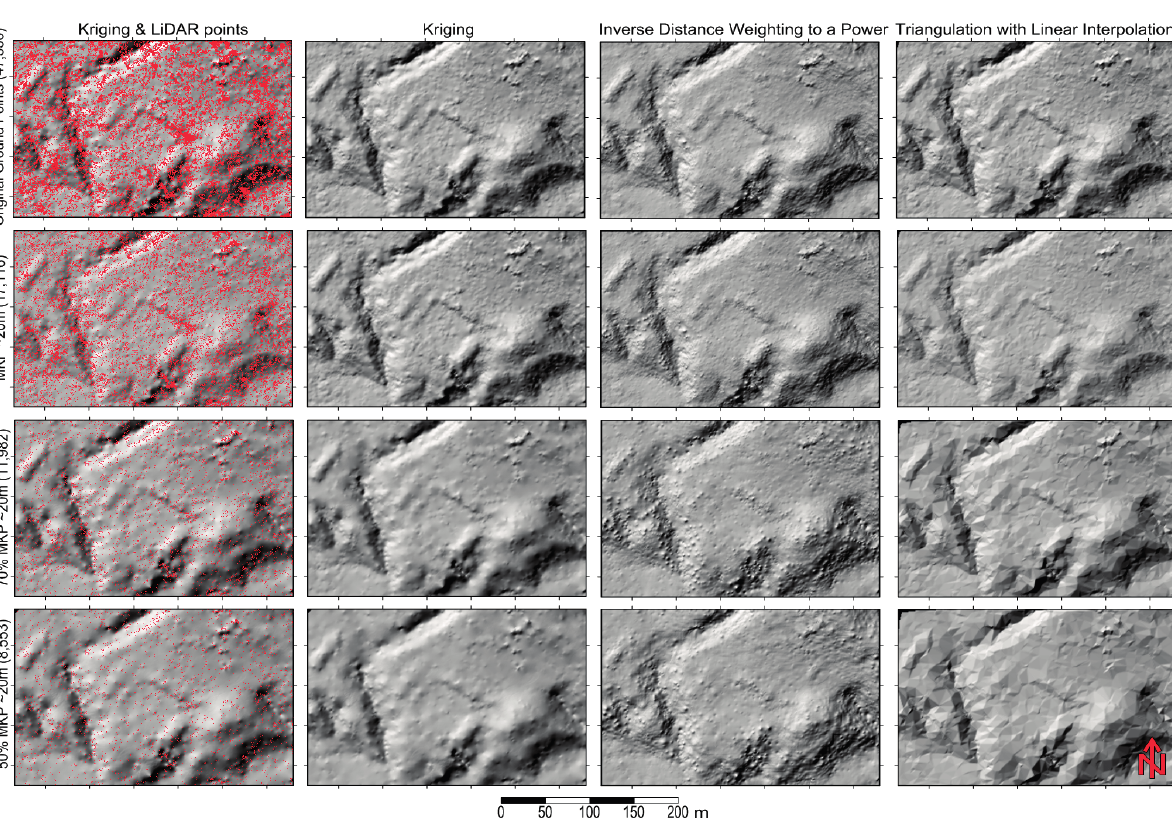
Figure 26. Results from a decimation and interpolation test to evaluate the degree of confidence of features in ALS DEMs. For each image row the same dataset is gridded using kriging, inverse distance weighting to a power and triangulation with linear interpolation based on: ( top row ) the original returns classified as ground; ( second row ) identification of the model key points (MKP) that allow to retain intengrity of features ~